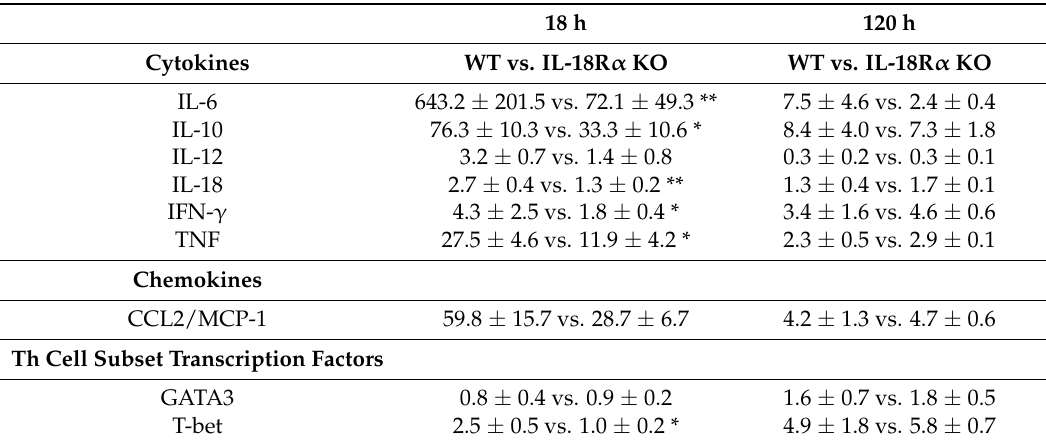
Table 1. Effect of IL-18R α on gene expression in LPS-induced AKI.